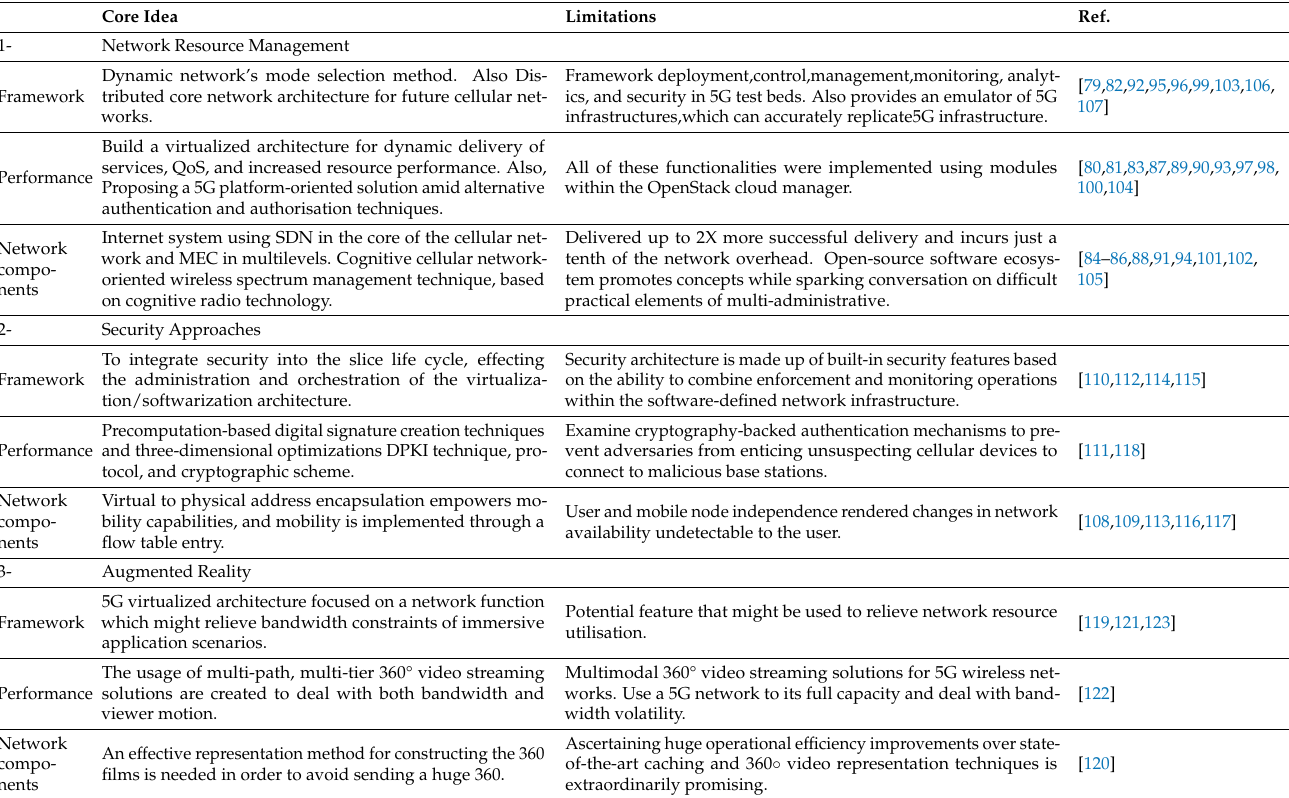
Table 3. The possible services, core idea, and solutions uses of the existing